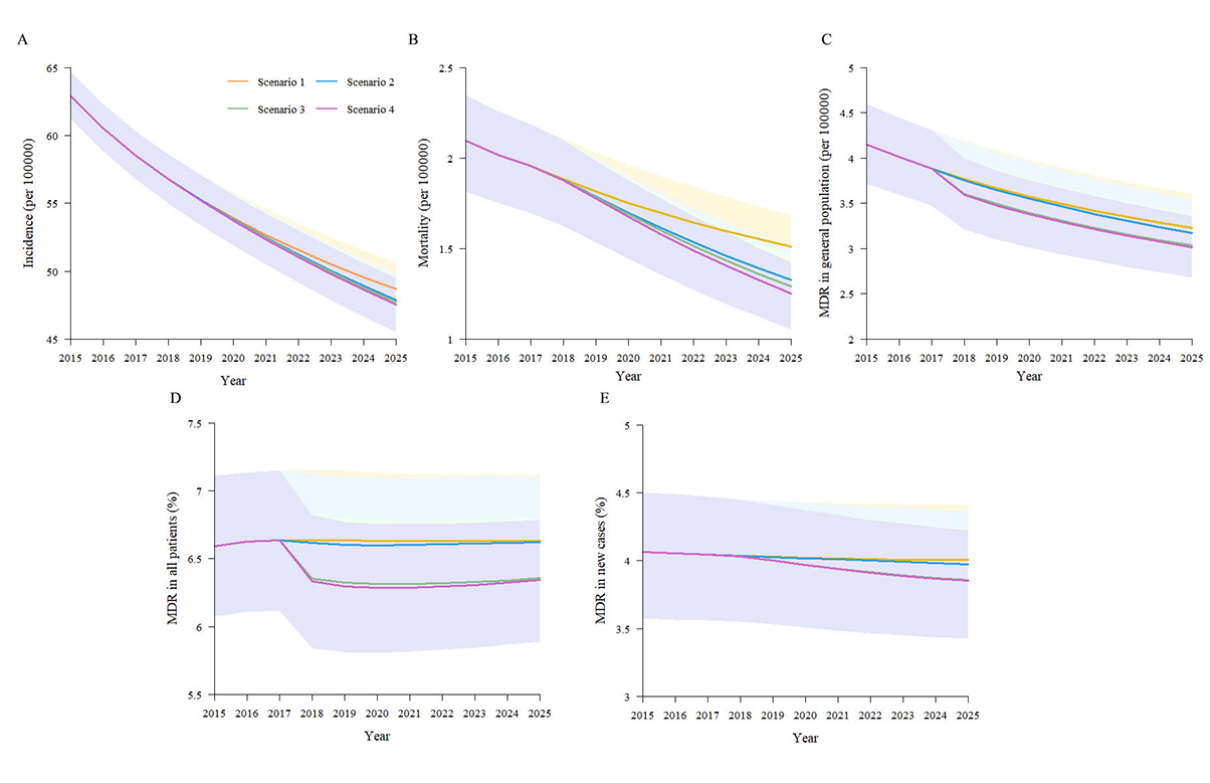
Figure 5. Expected impact of different scenarios of tuberculosis (TB) control on the prevalence of TB in Henan province, China, 2015-2025. A: Expected impact of different scenarios of TB control on the annual TB incidence. B: Expected impact of different scenarios of TB control on the annual TB mortality. C: Expected impact of different scenarios of TB control on the percentage of multidrug-resistant tuberculosis (MDR-TB) in the general population. D: Expected impact of different scenarios of TB control on the percentage of MDR-TB in all TB cases. E: Expected impact of different scenarios of TB control on the percentage of MDR-TB in new TB cases.